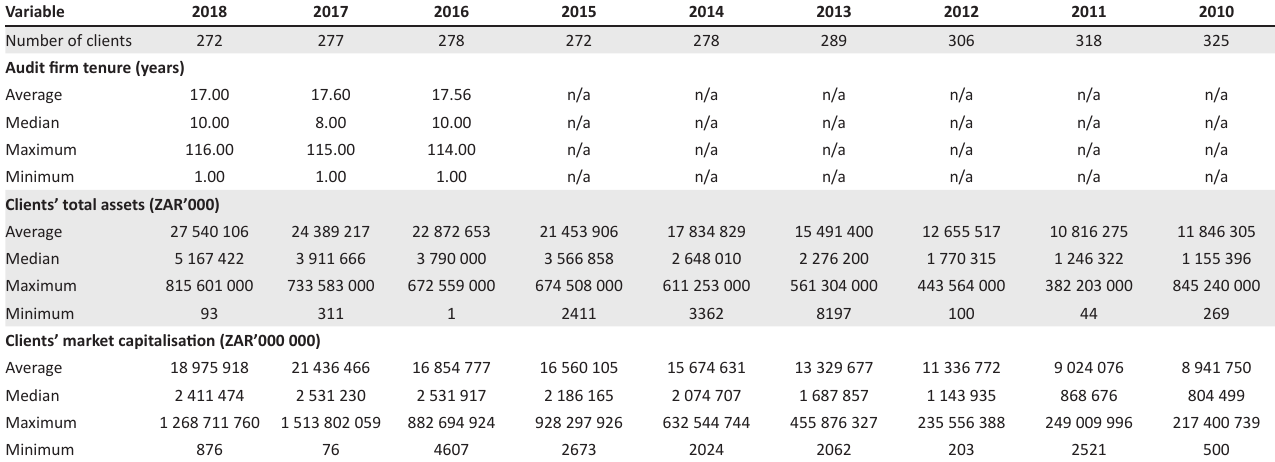
TABLE 2: Descriptive statistics on audit firm tenure and client